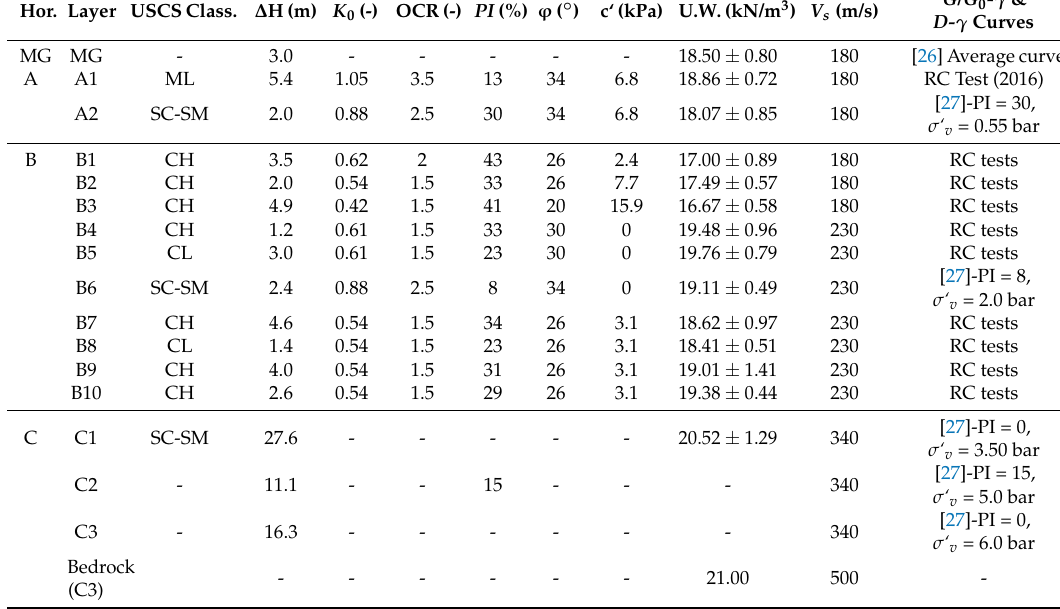
Table 1. Subsoil model adopted for site response analysis.